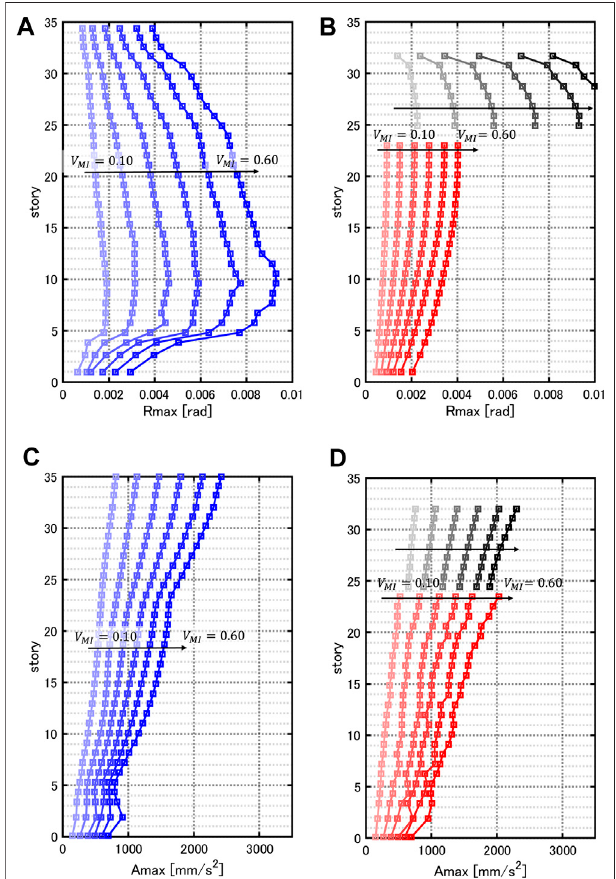
FIGURE 3 | Double impulse pushover (DIP) analysis of maximum interstory drifts and one-cycle sinusoidal input analysis of maximum accelerations for elastic-plastic 3-D frame with deformation-concentration seismic control system ( V DI (cid:1) 0 . 20 ∼ 1 . 00 [ m / s ] with increment 0 . 20 [ m / s ] ), (A) Maximum interstory drift angle of main frame, (B) Maximum interstory drift angle of sub frame, (C) Maximum acceleration of main frame, (D) Maximum acceleration of sub frame.